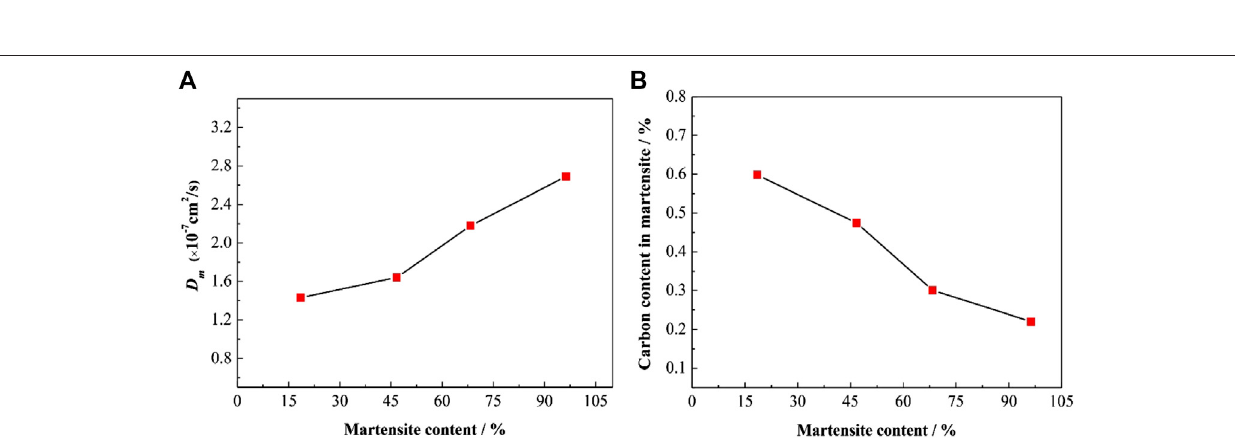
FIGURE 12 | (A) The hydrogen diffusion coef fi cient in martensite and (B) calculated carbon concentration vs the martensite content.